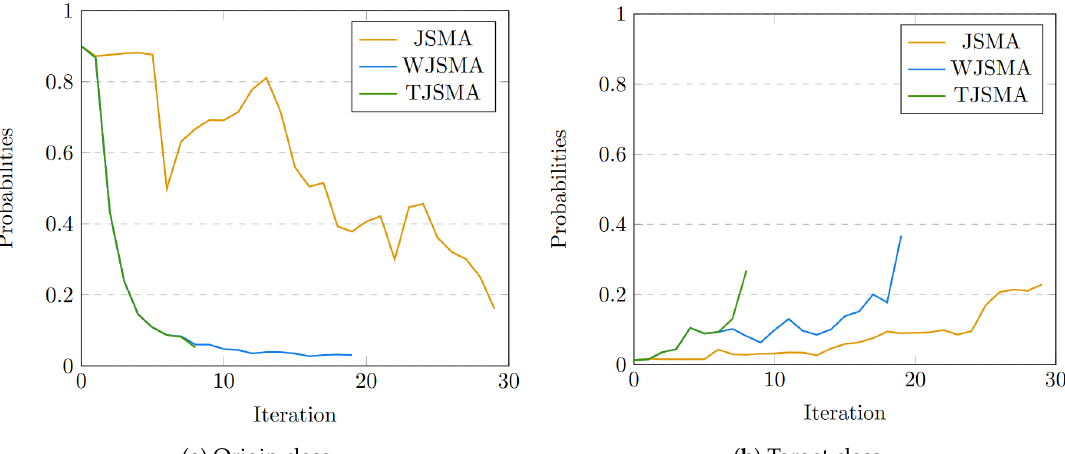
Figure 1. Evolution of the ( a ) origin class and ( b ) target class probabilities until the target class is reached for JSMA, WJSMA and TJSMA changing the image of a one into a